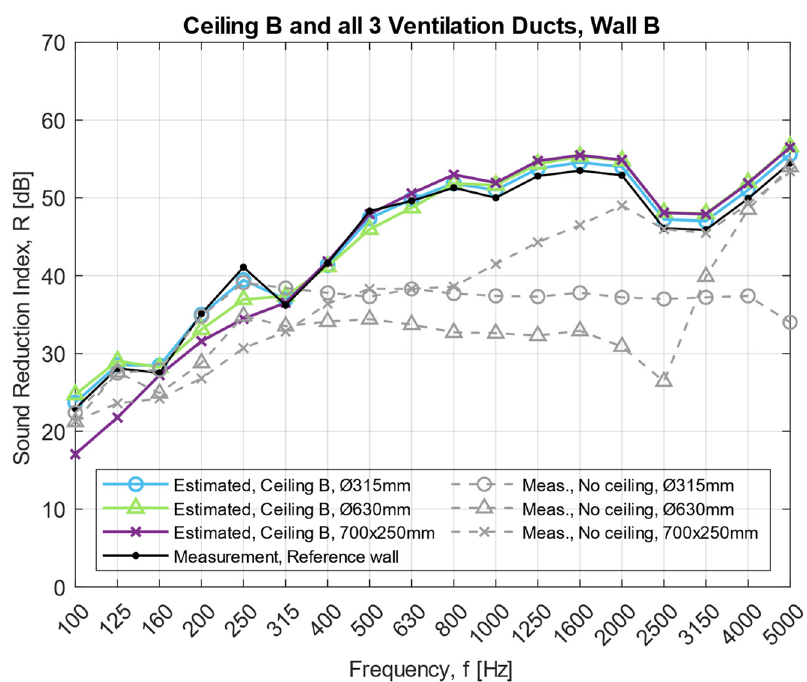
Figure A7. Estimated theory with suspended absorbent ceiling, Ceiling B, as acoustical treatment. Ventilation duct with dimensions of: Ø315, Ø630 and 700 × 250 mm through wall B with a sound reduction index of R w = 46 dB.